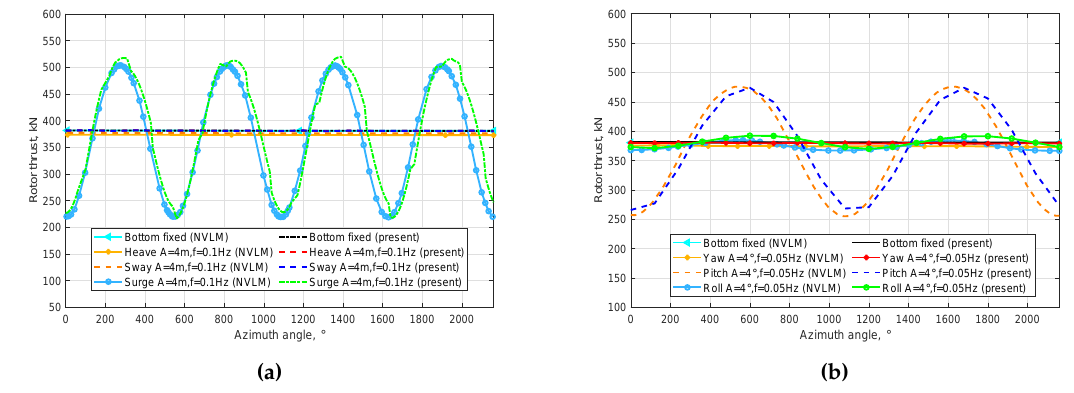
Figure 8. Thrust with: ( a ) translational motions ( A = 4 m, f = 0.1 Hz); and ( b ) rotational motions ( A = 4 ◦ , f = 0.05